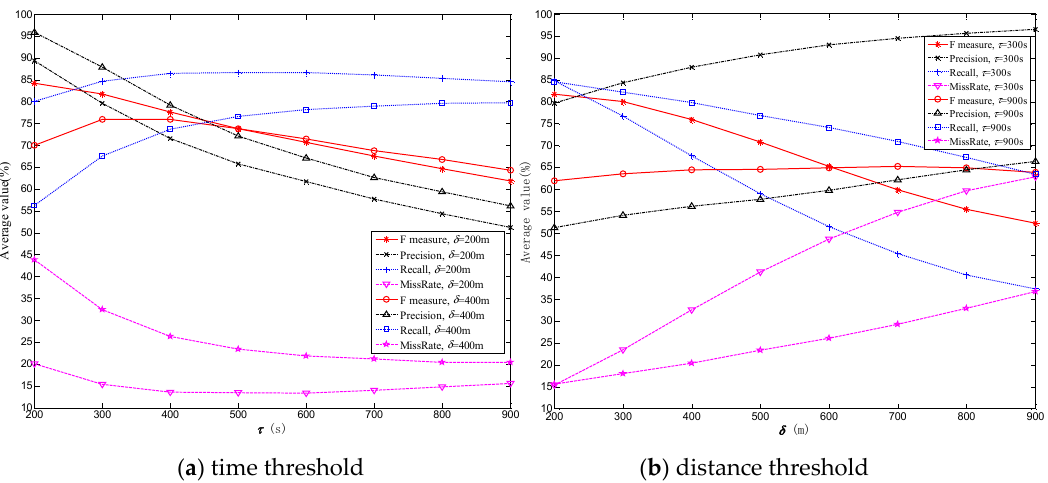
Figure 7. The running results on dataset DS1 . In this figure, the parameters of the StayPointDetection algorithm are changed.